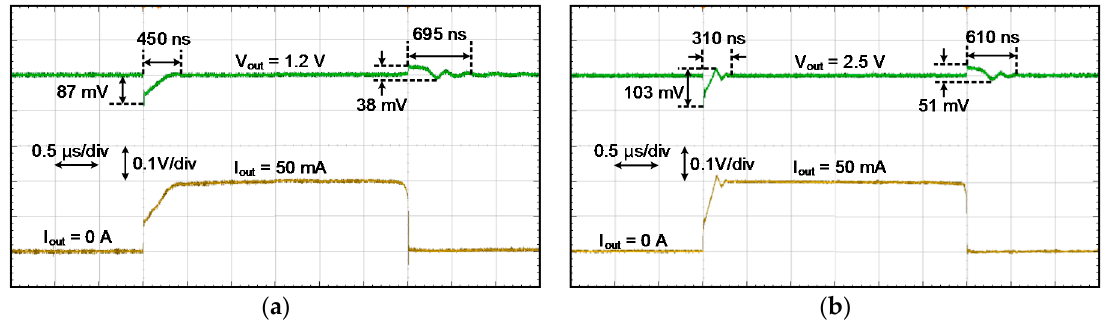
Figure 11. Measured load transient responses with C L = 100 pF and I out = 0 to 50 mA. ( a ) V in = 1.4 V and V out = 1.2 V; ( b ) V in = 2.7 V and V out = 2.5 V.